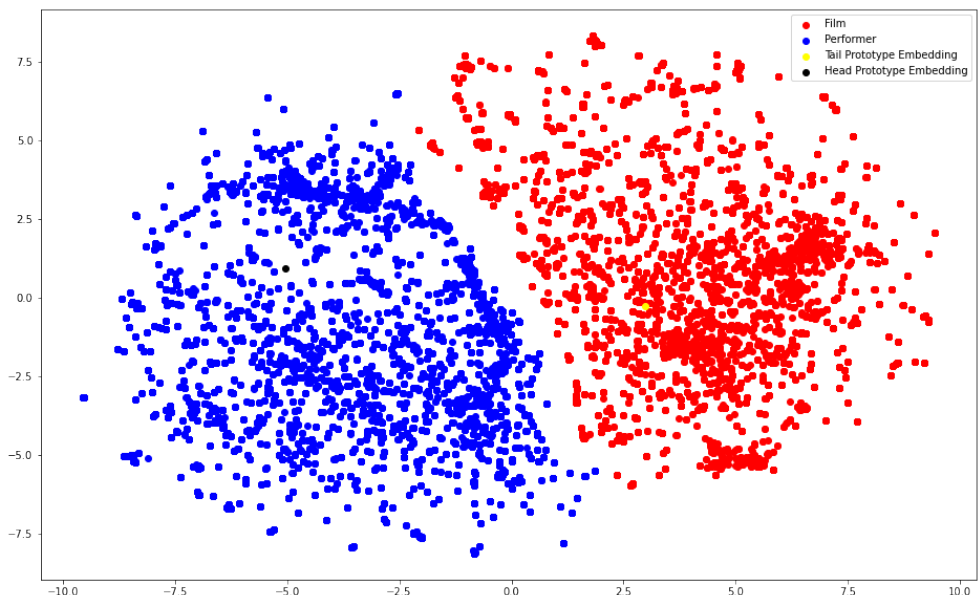
Figure 5. Entity and prototype embeddings related to performed_in in the dataset FB15k-237.